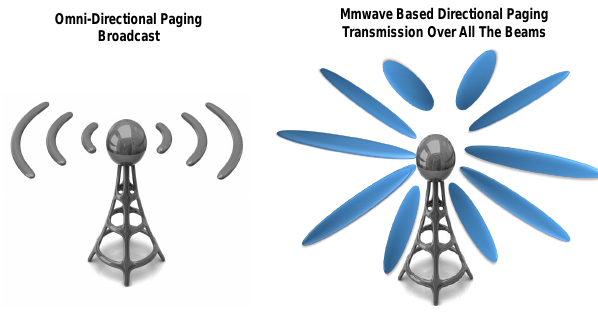
Figure 1. Directional air interface in 5G